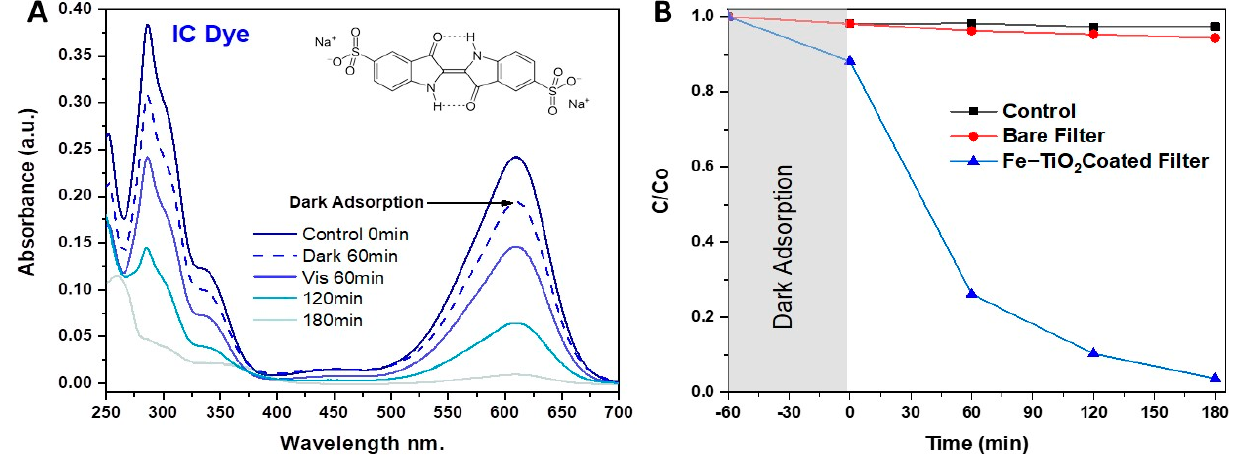
Figure 3. ( A ) The UV–Vis absorbance spectra of indigo carmine (IC) dye vs. irradiation at a different time and with the Fe-TiO 2 -coated filter; ( B ) relative concentrations (C/Co) of the IC with the control, bare, and coated filter.